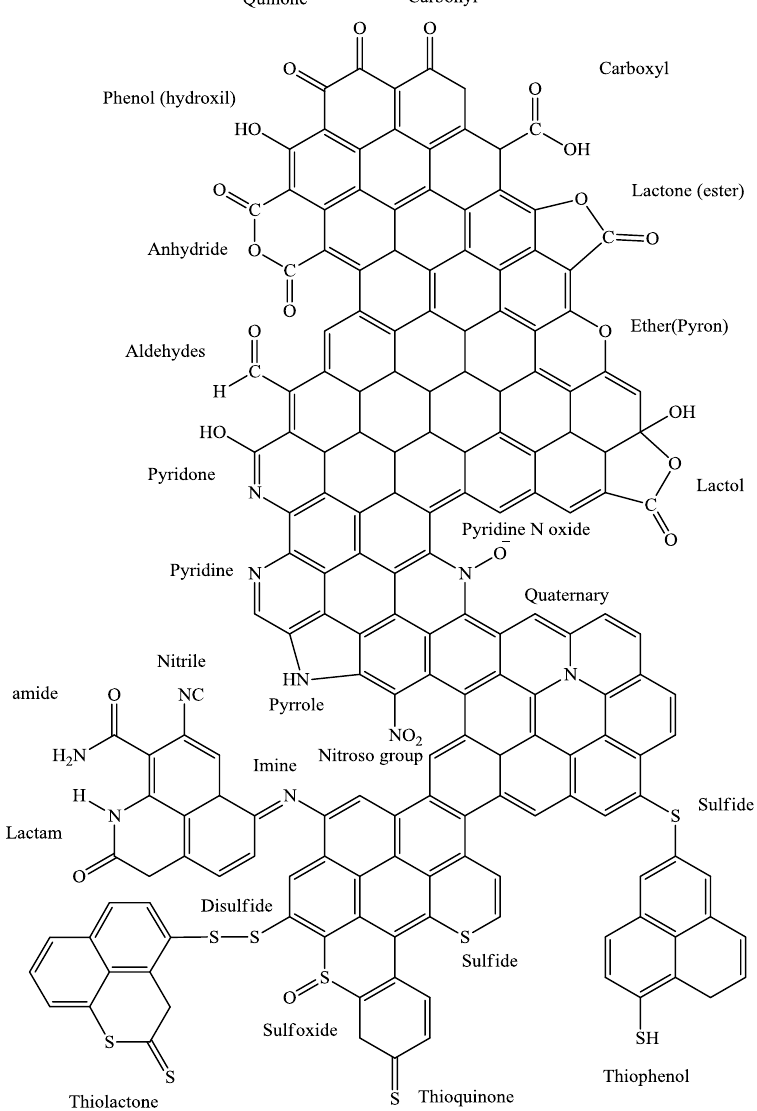
Figure 1. Oxygen, sulfur, and nitrogen functional groups on the surface of activated carbon.